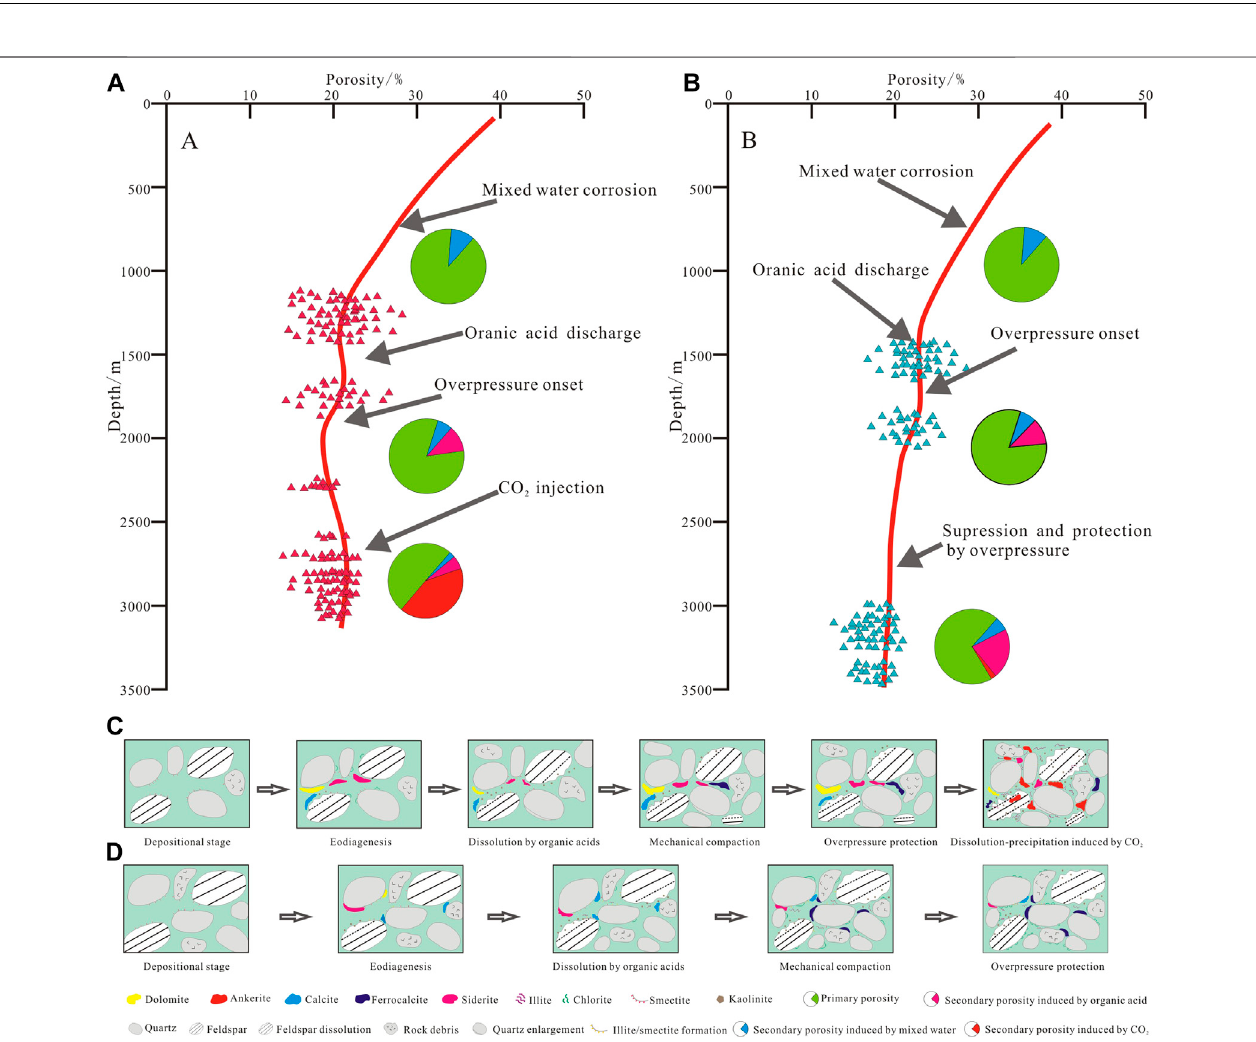
FIGURE15| TrendofporosityevolutionwithdepthintheAF-1area (A) andtheAF-2area (B) ,anddiageneticevolutionoftheHuangliusandstonesintheAF-1area (C) and the AF-2 area (D) in the Dongfang district.